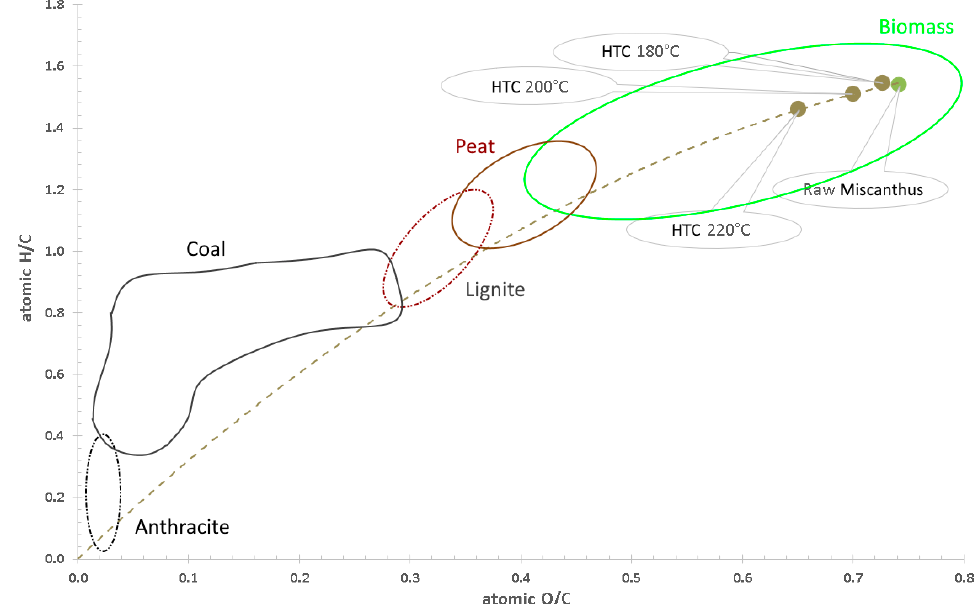
Figure 9. Van Krevelen’s diagram for the raw sample, before HTC, and hydrochars obtained at respective temperatures (locations of different solid fuels adapted from [103–108]).